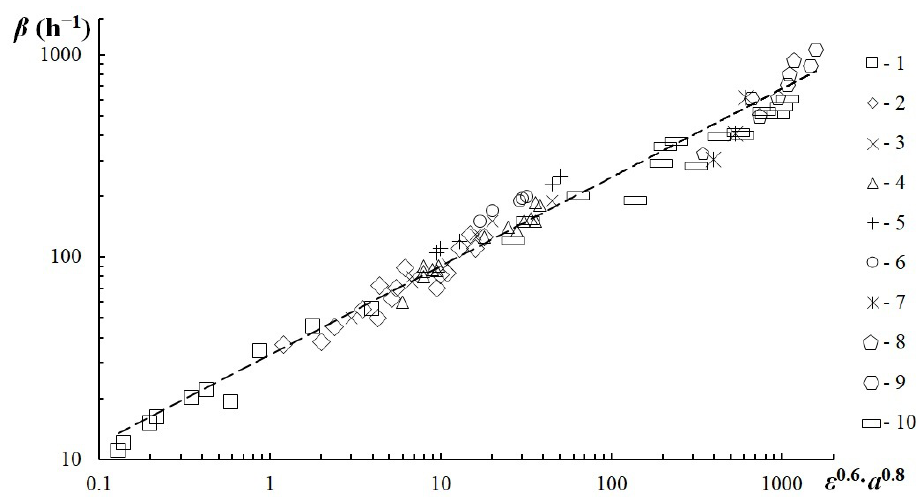
Figure 19. Change in the mass transfer coefficient from the parameter ε 0.6 · a 0.8 . Experimental points (1–6) according to [48] during bubbling; (7–9) data of the studied method according to the intensive dispersion scheme (Figure 1e): 7— H L = 0.05 (m); 8— H L = 0.3 (m), 1 partition; 9— H L = 0.3 (m), 3 partitions; 10—data [49] apparatus with a stirrer.